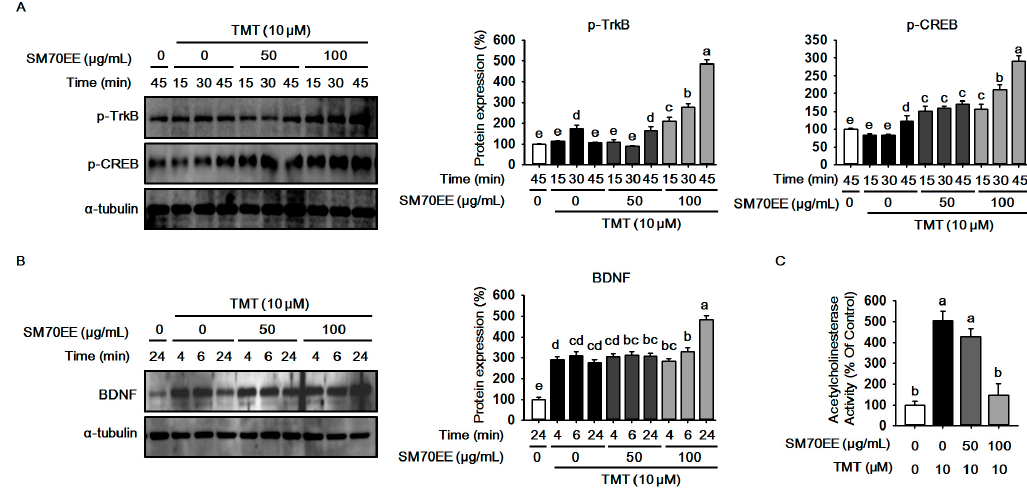
Figure 3. SM70EE prevents neuronal cell damage through enhancing BDNF/CREB signaling pathways and suppressing AChE activity against TMT-induced neurotoxicity in HT-22 cells. ( A ) Proteins were harvested at the indicated time points and subjected to western blot analysis to probe the expressions of p-CREB, p-TrkB; ( B ) Proteins were harvested at the indicated time points and subjected to western blot to analyze to the expression of BDNF. The protein expression level was quantified using Image J software and normalized against α -tubulin and control; ( C ) HT-22 cells were pre-treated 50 and 100 μ g/mL SM70EE for 4 h before treatment with 10 μ M TMT for 24 h. AChE activity was measured by Ellman method. The experiments were performed in tri-plicate. Results were analyzed by one-way ANOVA and Duncan’s multiple range tests. The p -value in the multiple comparison results (e.g., a, b, c, and d) indicate significant differences among the groups ( p < 0.05).